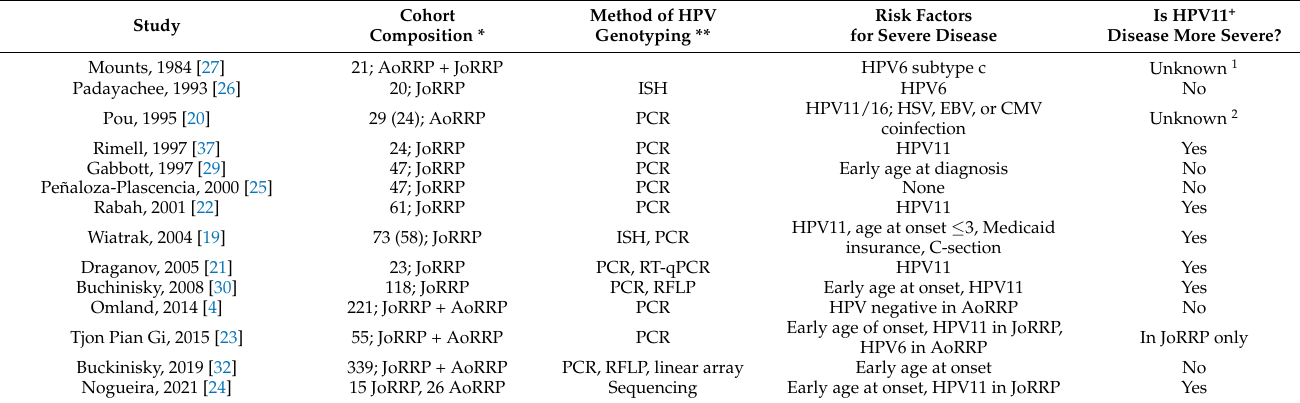
Table 1. Cohorts of RRP evaluating risk factors, in order of publication